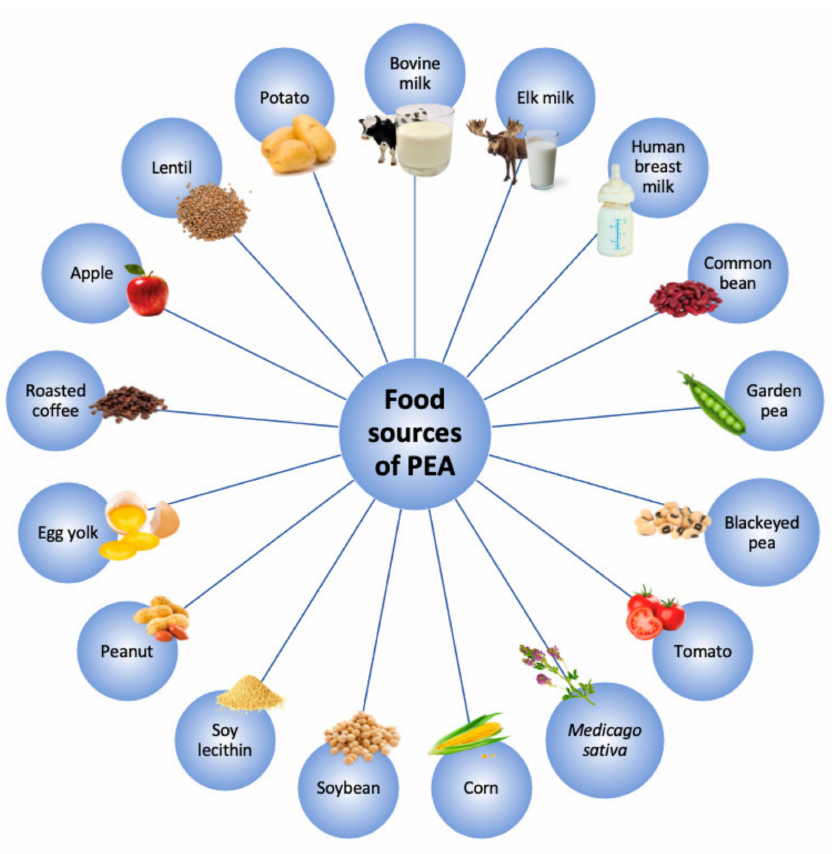
Figure 1. Main food sources of palmitoylethanolamide